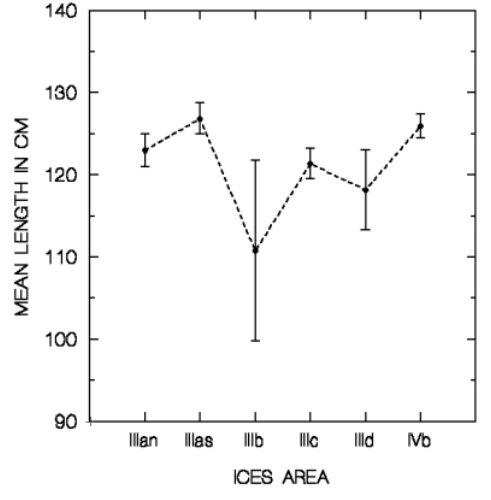
Fig. 11. Mean lengths ± S.E. of porpoises by ICES area for all years. Sample sizes are IIIan:112, IIIas:100, IIIb:10, IIIc:224,